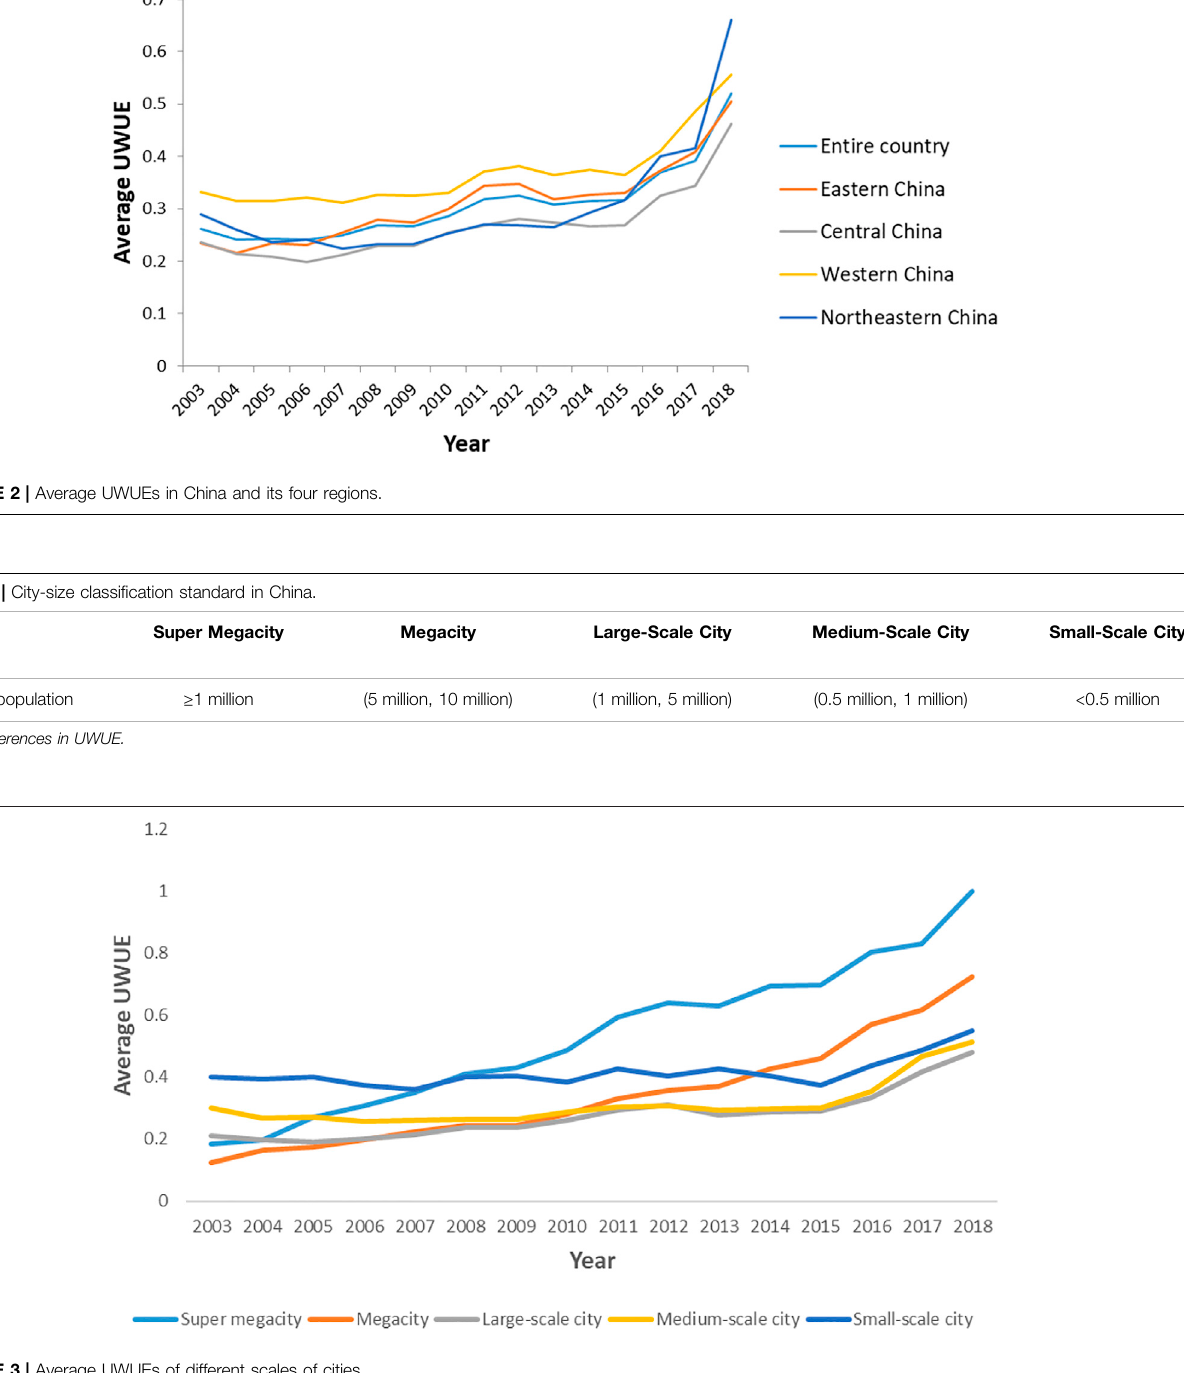
FIGURE 3 | Average UWUEs of different scales of